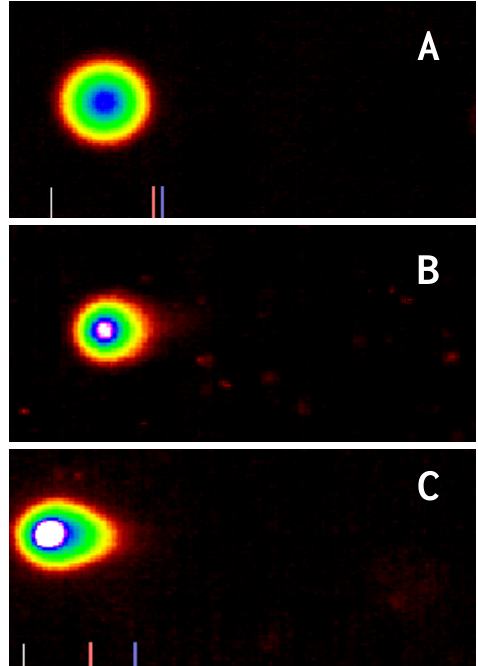
Figure 2: Representative SYBR Green Comet assay images of untreated (A-control) and VA leaf extracts- treated MCF-7 cells at 0.5 mg/mL (B) , and 2 mg/mL (C)